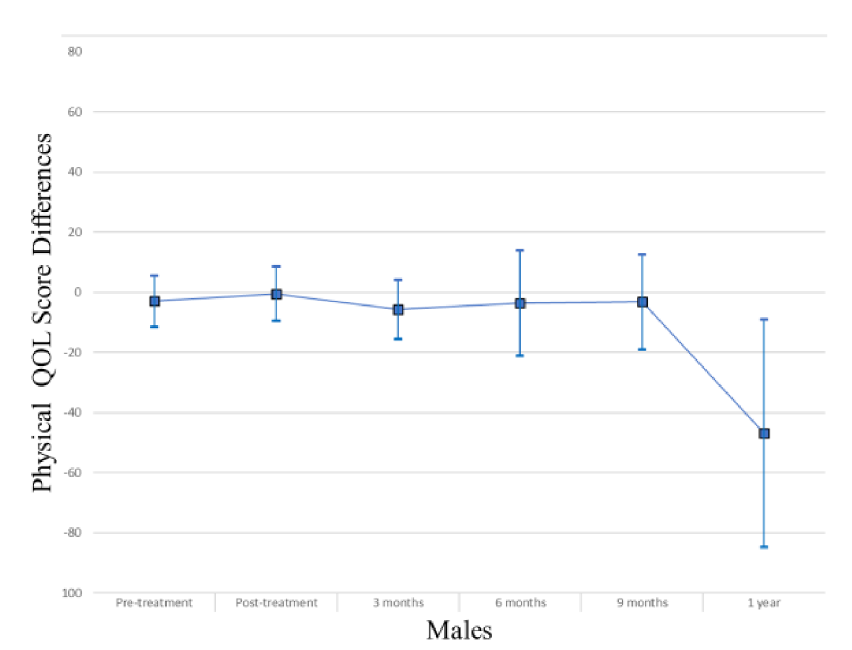
Figure 5. Physical QOL score differences in male study